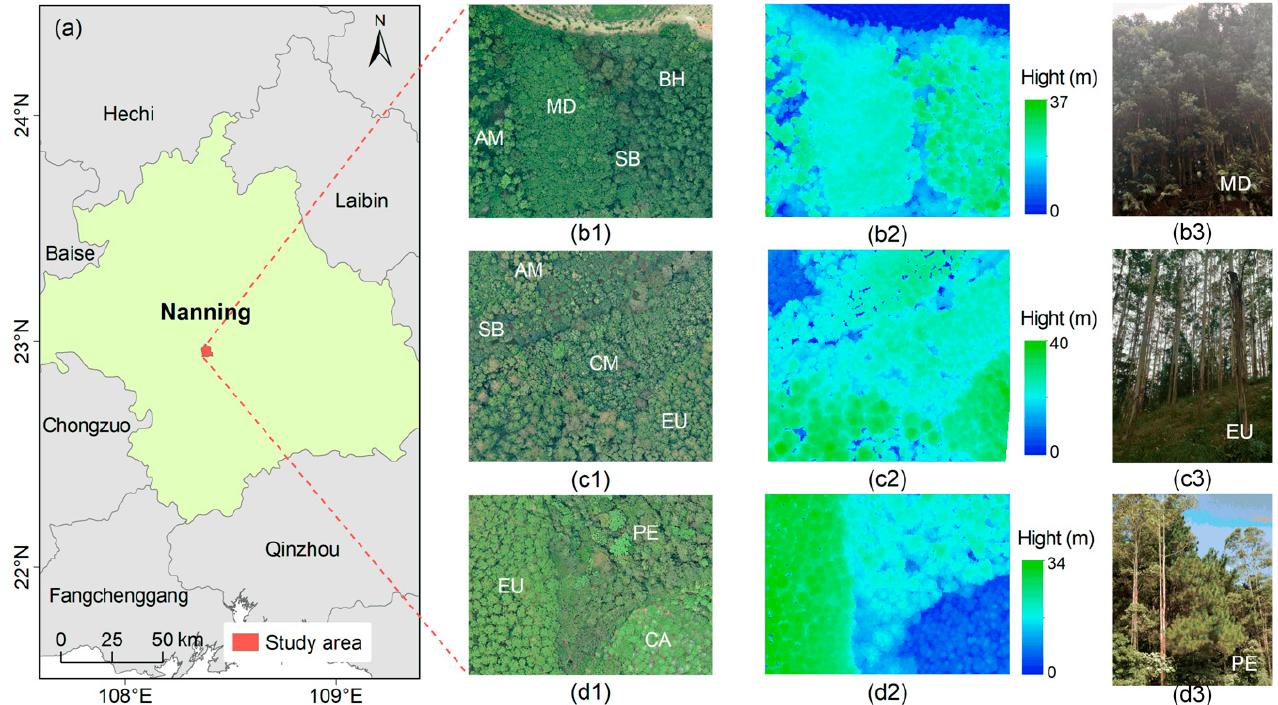
Figure 1. Overview of the study areas. ( a ) Location of the study area. ( b – d ) UAV-RGB images, CHM, and photographs of the main tree species for the three experimental areas, respectively.